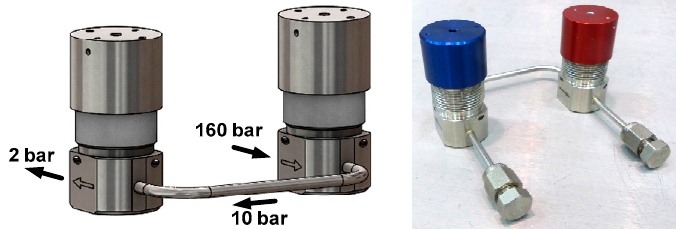
Figure 14. Illustration (left) and photograph (right) of the Adelis-SAMSON pressure regulators.